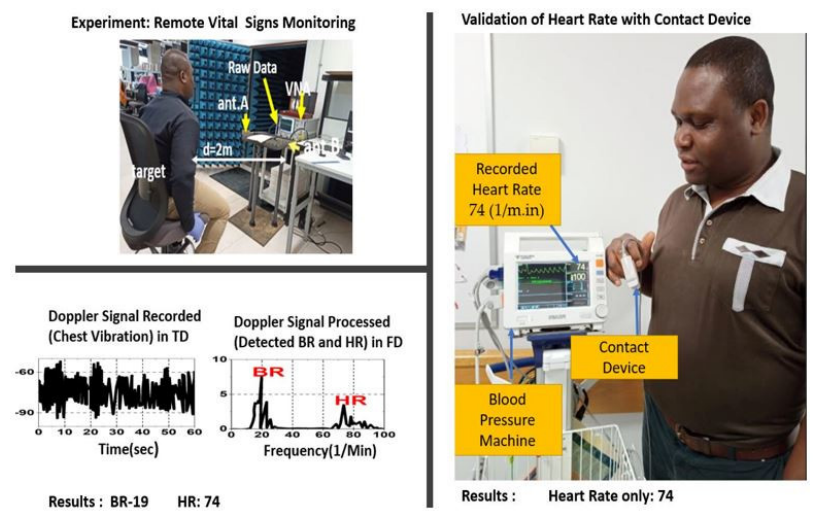
Figure 15. Validation of RVSM using (LHS) non-contact device (RHS) traditional blood pressure machine.